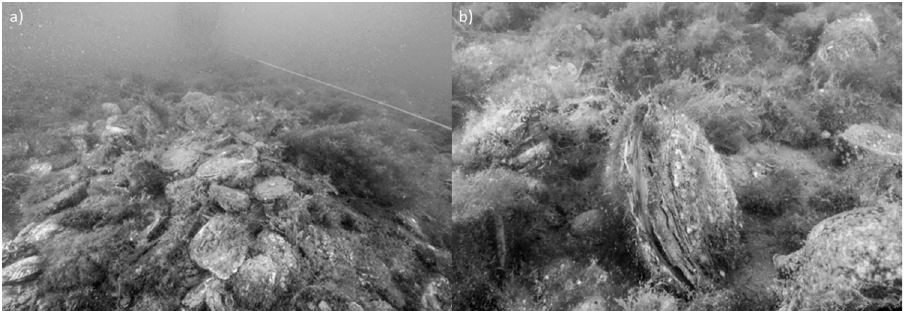
Fig 7. Examples of a developed oyster reef in Loch Ryan Treatment 3. a) An area of oyster reef demonstrating high density of adult sized oysters. b) A close up of an adult sized oyster. (Photo credit: Richard Shucksmith).